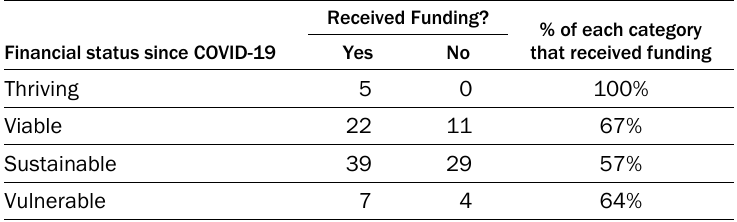
Table 9. Financial Status Since COVID-19 by Whether Businesses